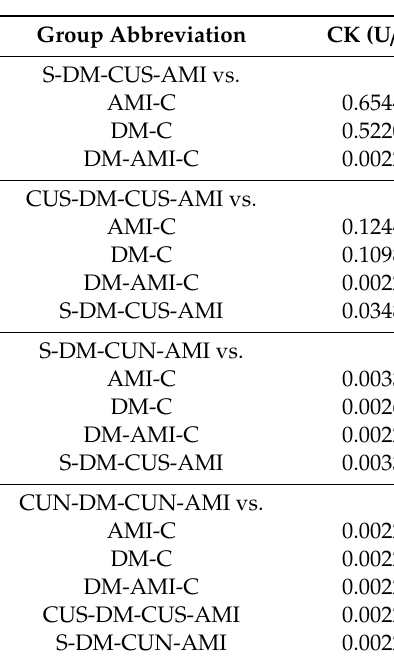
Table 4. P -values for comparisons between the study groups for myocardial infarction enzymes.